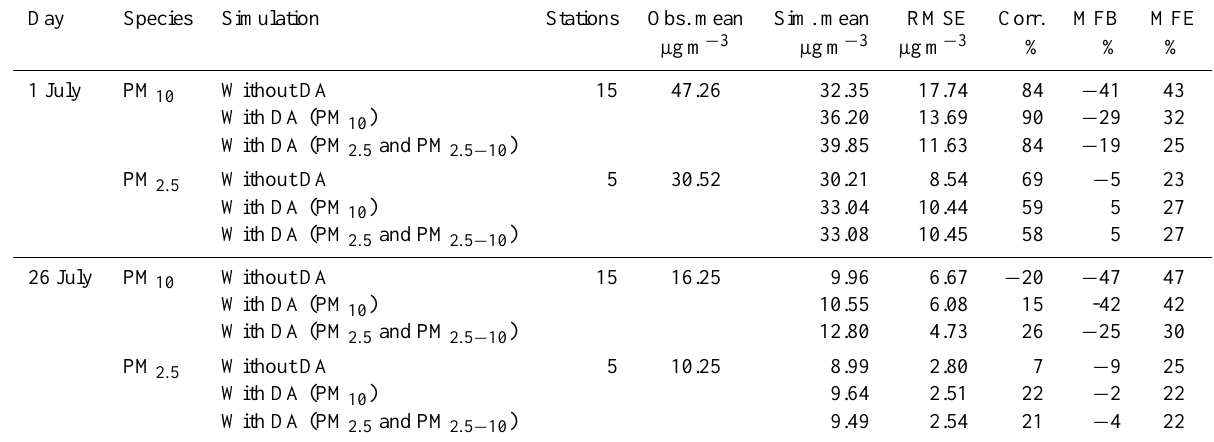
Table 4. Statistics (see Appendix A) of the simulation results (PM 10 and PM 2 . 5 ) without DA and with DA for the Airparif network for 1 and 26 July 2009. “With DA (PM 10 )” stands for the assimilation of lidar observations correcting PM 10 directly. “With DA (PM 2 . 5 and PM 2 . 5 − 10 )” stands for the assimilation of lidar observations correcting PM 2 . 5 and PM 2 . 5 − 10 separately. Day Species Simulation Stations Obs. mean Sim. mean